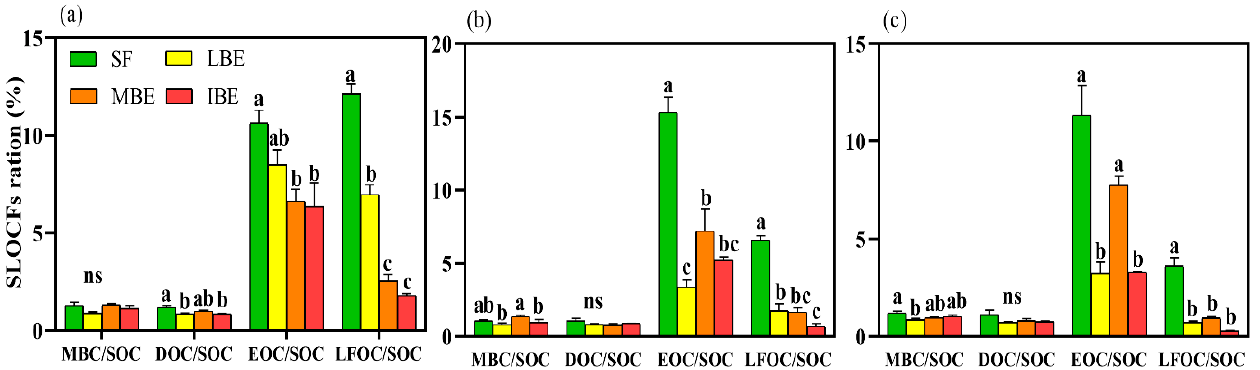
Figure 4. Proportion of SLOCFs in different bedrock exposure rates. MBC/SOC, DOC/SOC, EOC/SOC, and LFOC/SOC represent the proportions of MBC, DOC, EOC and LFOC to SOC, respectively. SF (secondary forest); LBE (light bedrock exposure); MBE (moderate bedrock exposure); IBE (intense bedrock exposure). Different lowercase letters indicate significant differences ( p < 0.05), ns is no significant. ( a – c ) Soil depths of 0–10 cm, 10–20 cm and 20–30 cm, respectively.